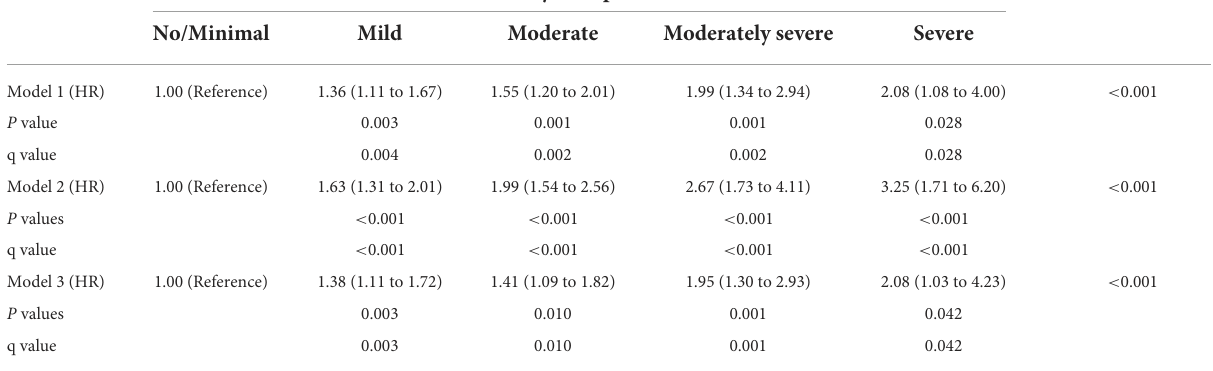
TABLE 4 Crude and adjusted association between depression level and all-cause mortality.